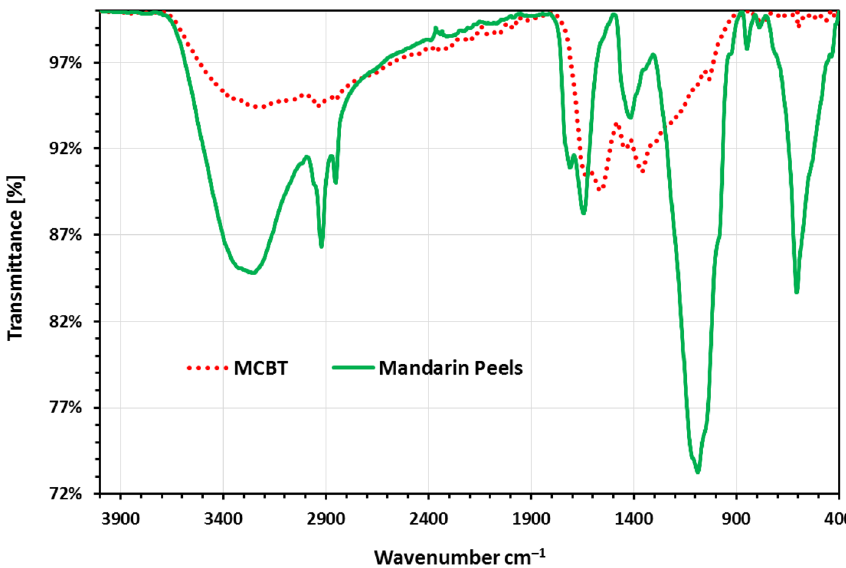
Figure 2. FTIR analysis of MP (green line) and MBT (red